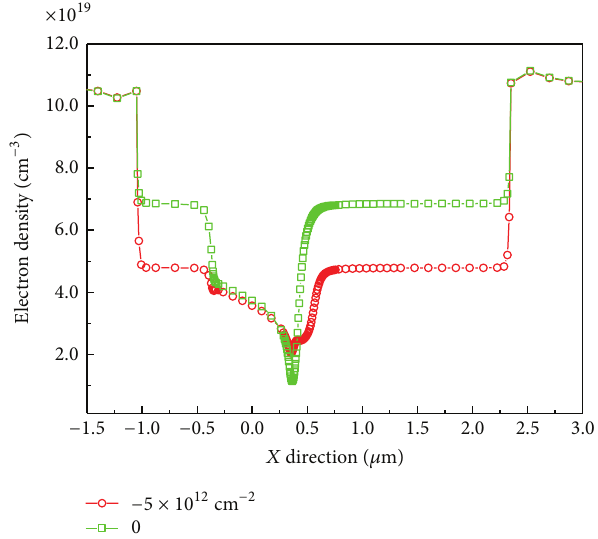
Figure 2: Electron density versus 𝑋 direction cut at AlGaN/GaN interface. A depletion of 2DEG in channel due to negative charges on the surface is